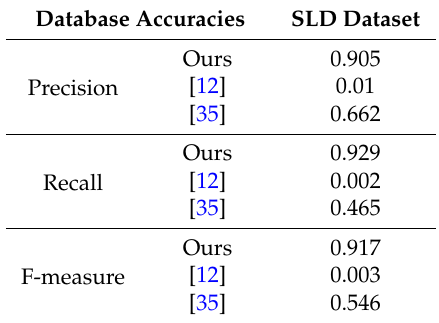
Table 5. Comparative accuracies of lane detection on SLD datasets.